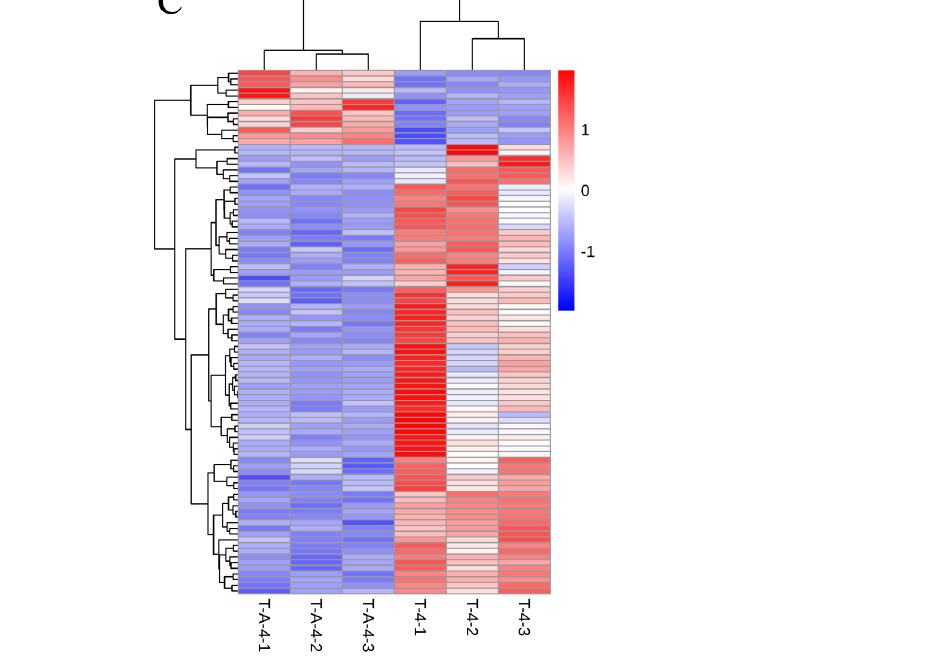
Figure 4. KEGG enrichment analysis of DEGs and their expression involved in the comparison of T-A-4 vs. T-4. ( A , B ) KEGG pathway enrichment analysis on up-regulated and down-regulated DEGs showed the distribution of metabolic pathways in pairwise comparison of T-A-4 vs. T-4 treatment. ( C ) The expression profiles of DEGs related to pairwise comparison of T-A-4 vs. T-4 treatment. The up-regulated DEGs were marked in red color, and down-regulated DEGs were marked in blue color in heatmap.